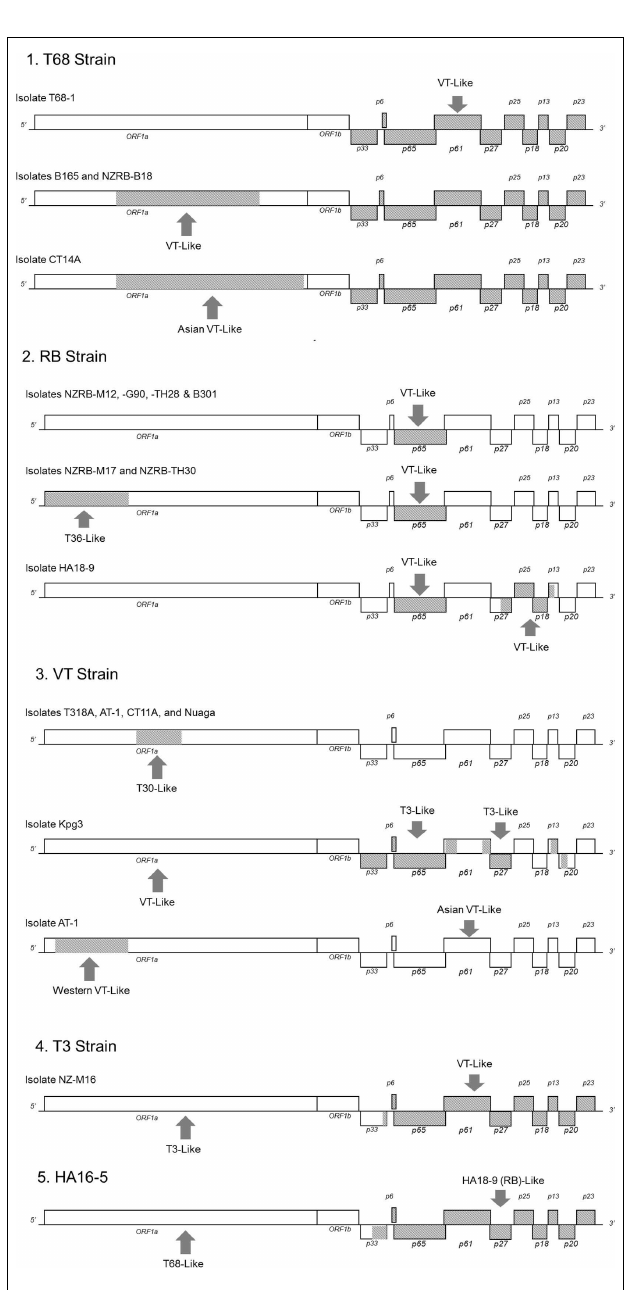
THE EVOLUTION OF CITRUS TRISTEZA VIRUS